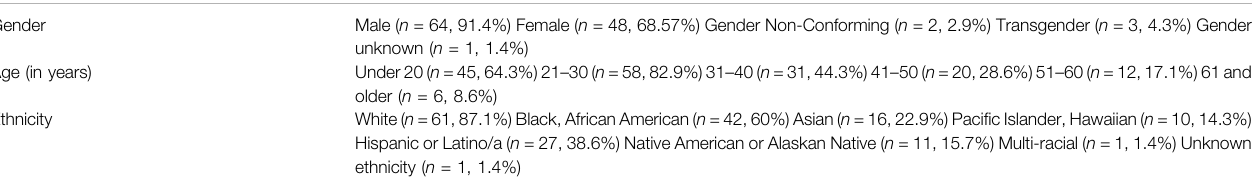
TABLE 4 | Demographics. Demographics of Those for which BFR was Applied to Gender